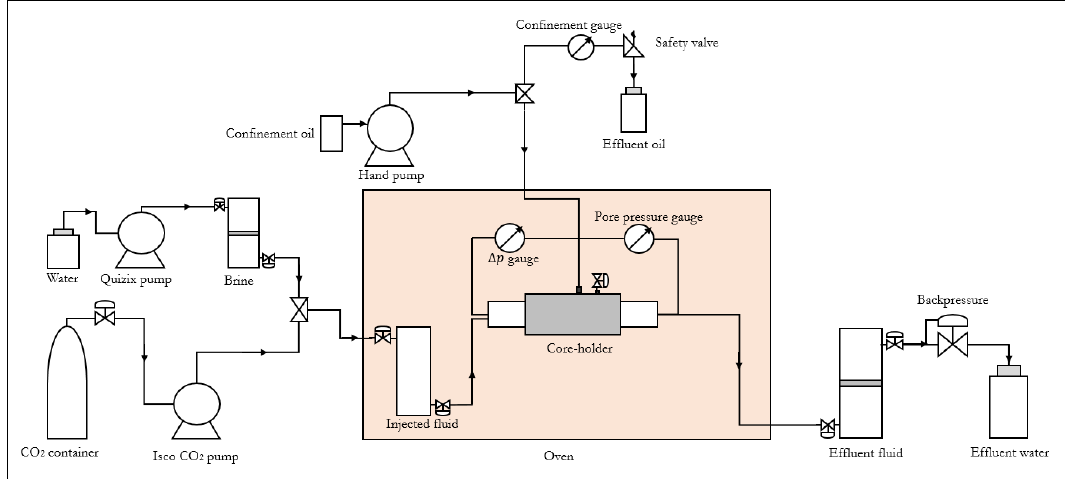
Figure 1. The CO 2 flow rig used for the core-flood tests .